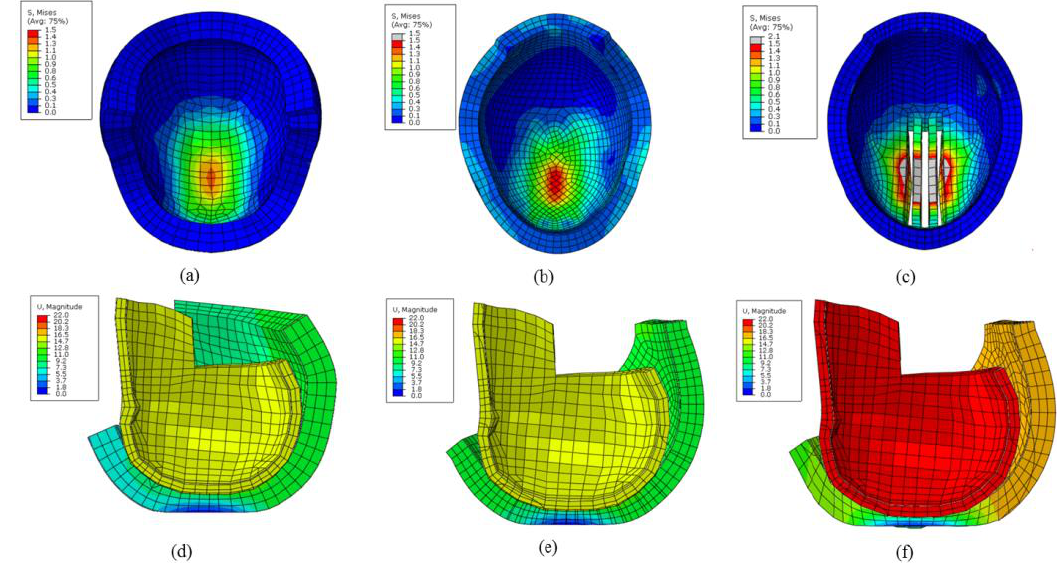
Figure 10. Stress contours of ( a ) the full; ( b ) open-face; and ( c ) 8-mm ventilation slot helmets; and the displacement contours of ( d ) the full; ( e ) open-face; and ( f ) 8-mm ventilation slot helmets during simulated impacts.